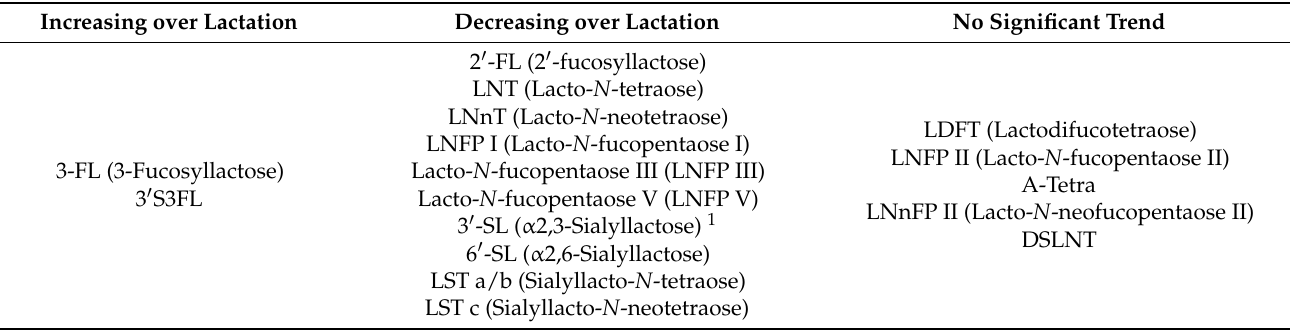
Table 5. Summary of changes in individual HMO concentrations throughout lactation.